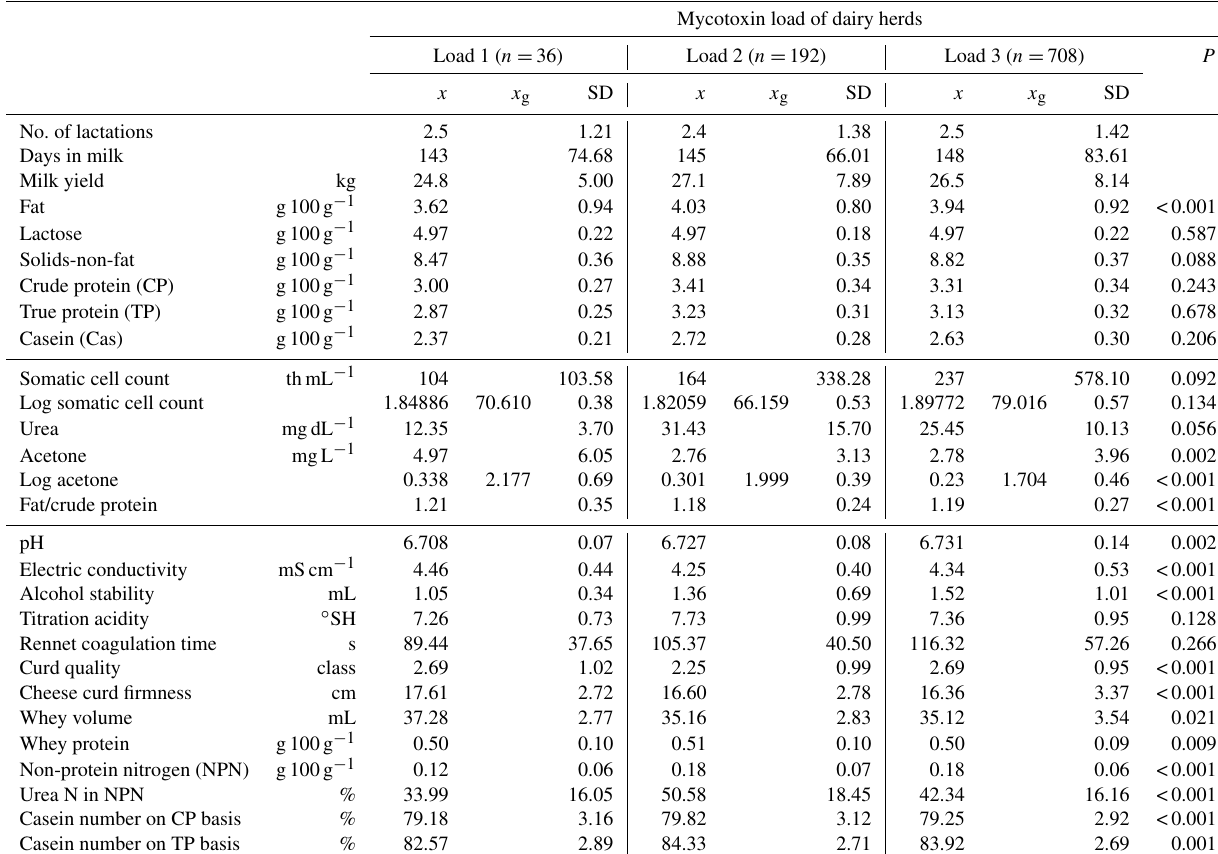
Table 4. Chemical, physical, and technological characteristics of milk depending on the mycotoxin load of dairy herds.